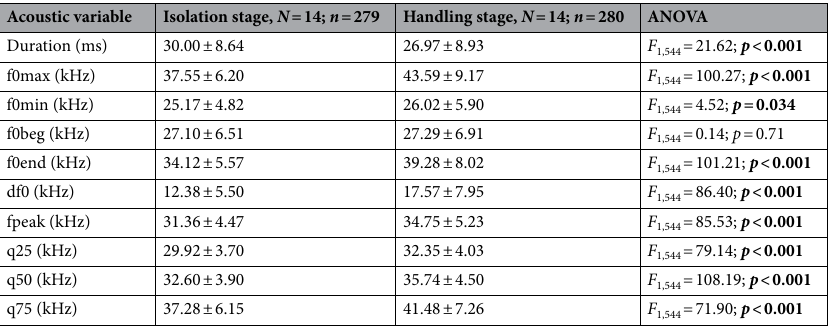
Table 3. Values (mean ± SD ) of the acoustic variables of single USVs and two-way ANOVA results for comparison between isolation and handling experimental stages. A total sample of USVs (with and without frequency jumps) was used. Animal individual identity was introduced in model as random factor. Designations: N —the number of individuals; n —the number of single USVs; f0max—the maximum fundamental frequency; f0min—the minimum fundamental frequency; f0beg—the fundamental frequency at the onset of a call; f0end—the fundamental frequency at the end of a call; df0—the depth of frequency modulation; fpeak—the frequency of maximum amplitude; q25, q50, q75—the lower, medium and upper quartiles. Significant values are marked in bold.